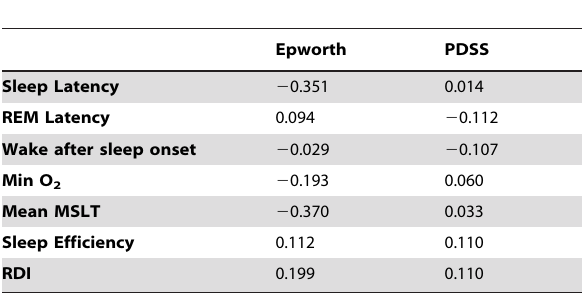
Table 4. Spearman correlation coefficients between sleep variables from polysomnography and subjective sleep